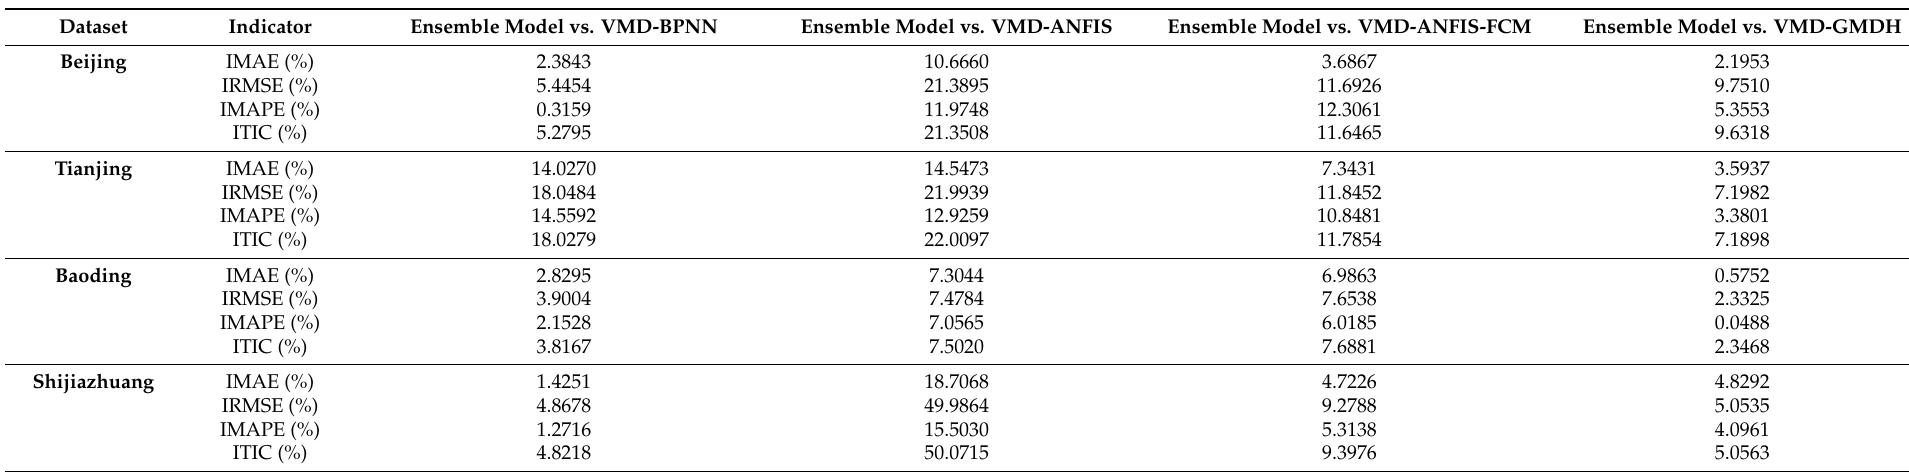
Table 4. The results of the ensemble model and other VMD-based models at four